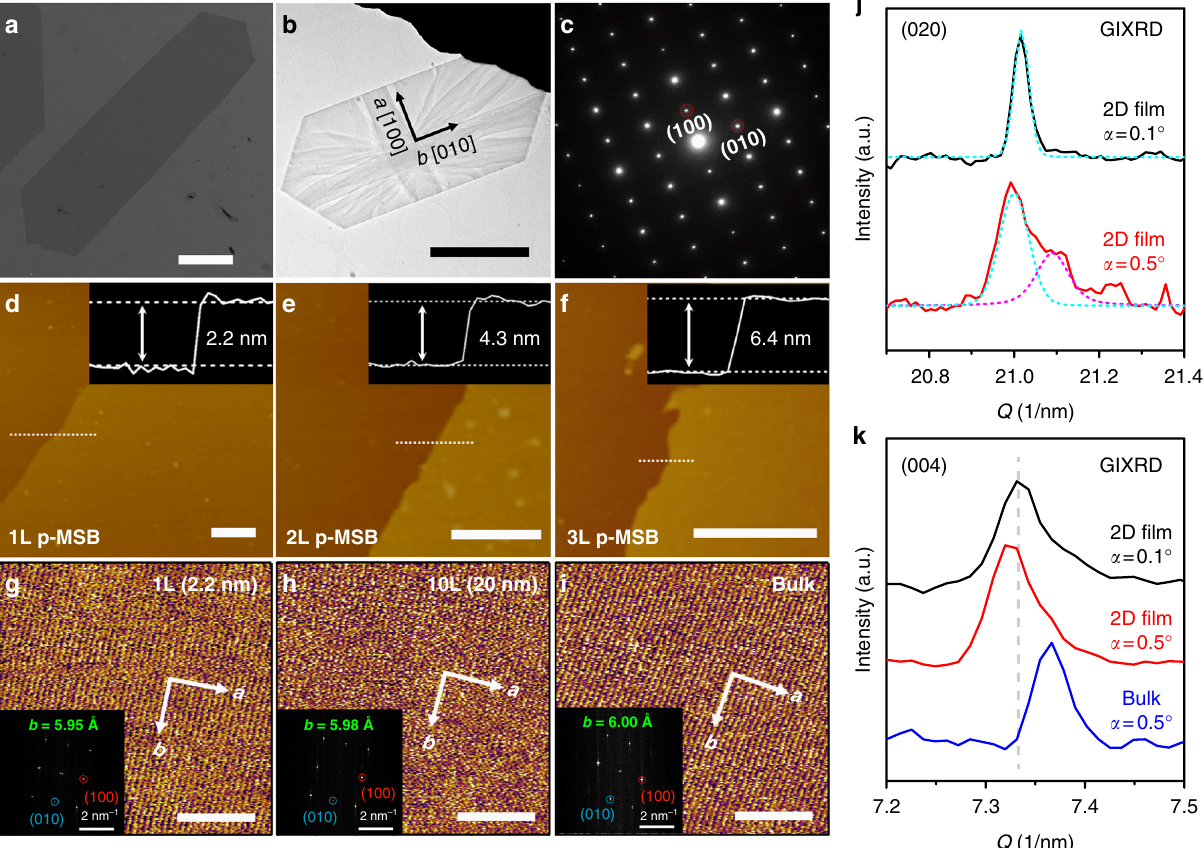
Fig. 2 As-grown 2D p-MSB crystal. a Scanning electron microscope (SEM) image of a typical millimeter-sized 2D p-MSB crystal grown on SiO 2 /Si. b Transmission electron microscope (TEM) image and c , the selected-area electron diffraction (SAED) analysis of a 2D p-MSB crystal. d – f AFM images of monolayer (1 L), bilayer (2 L), and trilayer (3 L) p-MSB on SiO 2 /Si, respectively. The insets are the corresponding height pro fi les across the dashed white lines in d – f . g – i High-resolution atomic force microscope (AFM) images of the monolayer (2.2 nm), thin- fi lm (20 nm), and bulk p-MSB crystals on SiO 2 /Si. The insets are the corresponding fast Fourier transforms (FFTs) of the high-resolution AFM images. j , k Grazing incident X-ray diffraction (GIXRD) patterns of the 2D p-MSB or bulk p-MSB fi lm for (020) and (004) as a function of scattering vector ( Q ), measured at different incidence angles ( α = 0.1° or 0.5°).